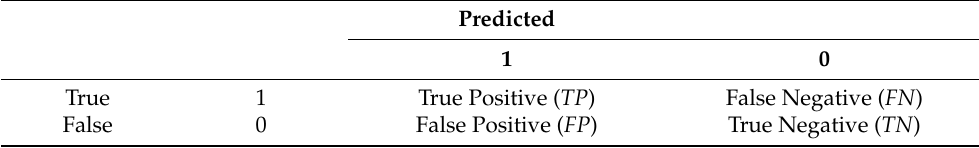
Table 4. Metrics of artifacts detection